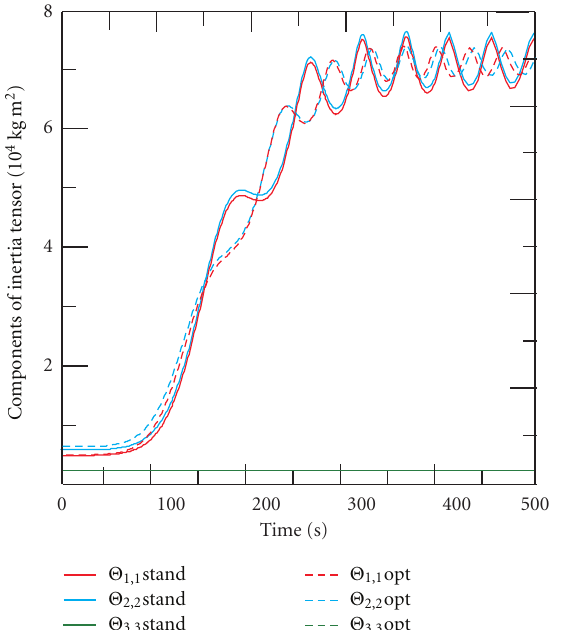
Figure 11: General coordinates z i versus time.